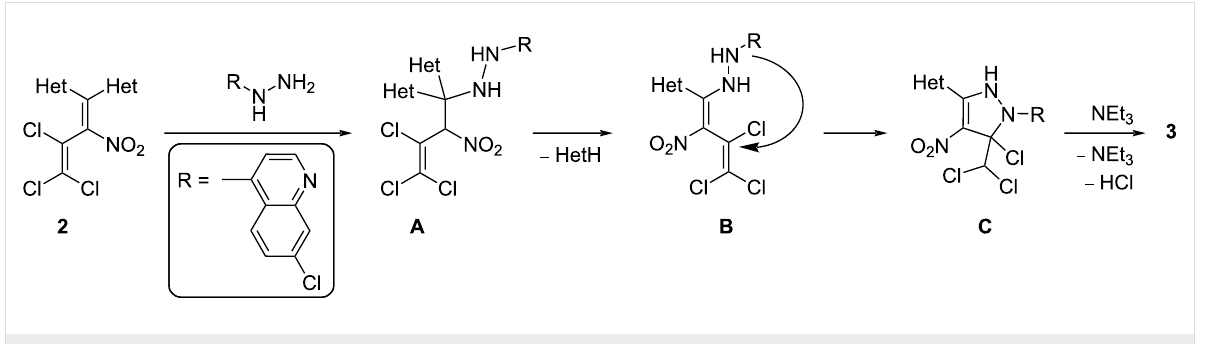
Scheme 2: Assumed mechanism for the formation of 1 H -pyrazoles 3a – c